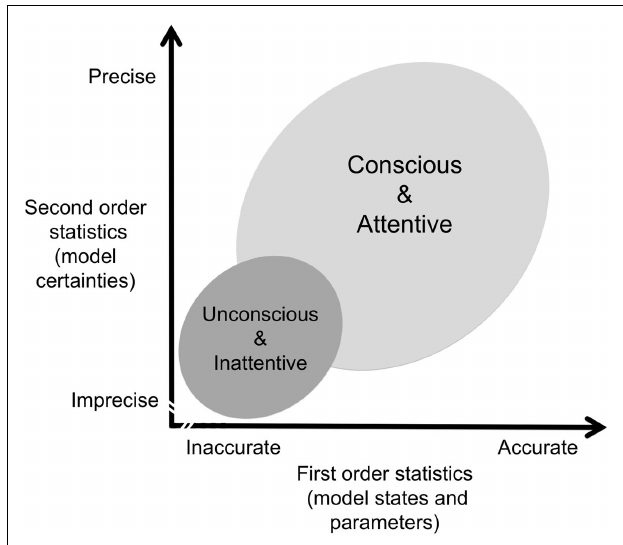
FIGURE 1 | Schematic of statistical dimensions of conscious perception. The accuracy afforded by first order statistics refers to the inverse amplitude of prediction errors per se , while the precision afforded by second order statistics refers to the inverse amplitude of random fluctuations around, or uncertainty about, predictions.This allows for a variety of different types of states such that in general, and depending on context, inattentive but conscious states would cluster towards the lower right corner and attentive but unconscious states would cluster towards the upper left; see main text for further